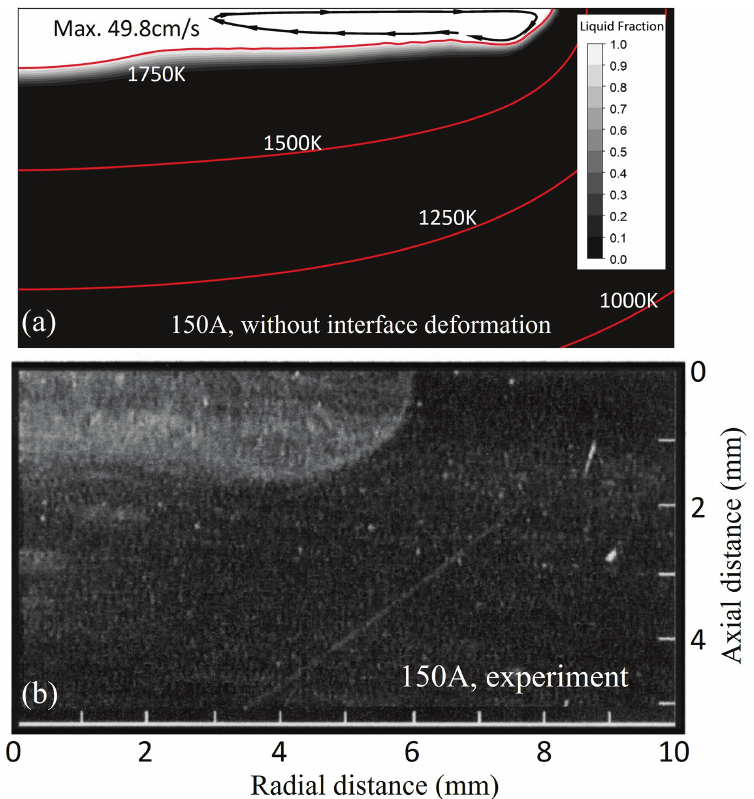
Figure 10: Weld pool shapes of (a) simulation with- out interface deformation and (b) experiment